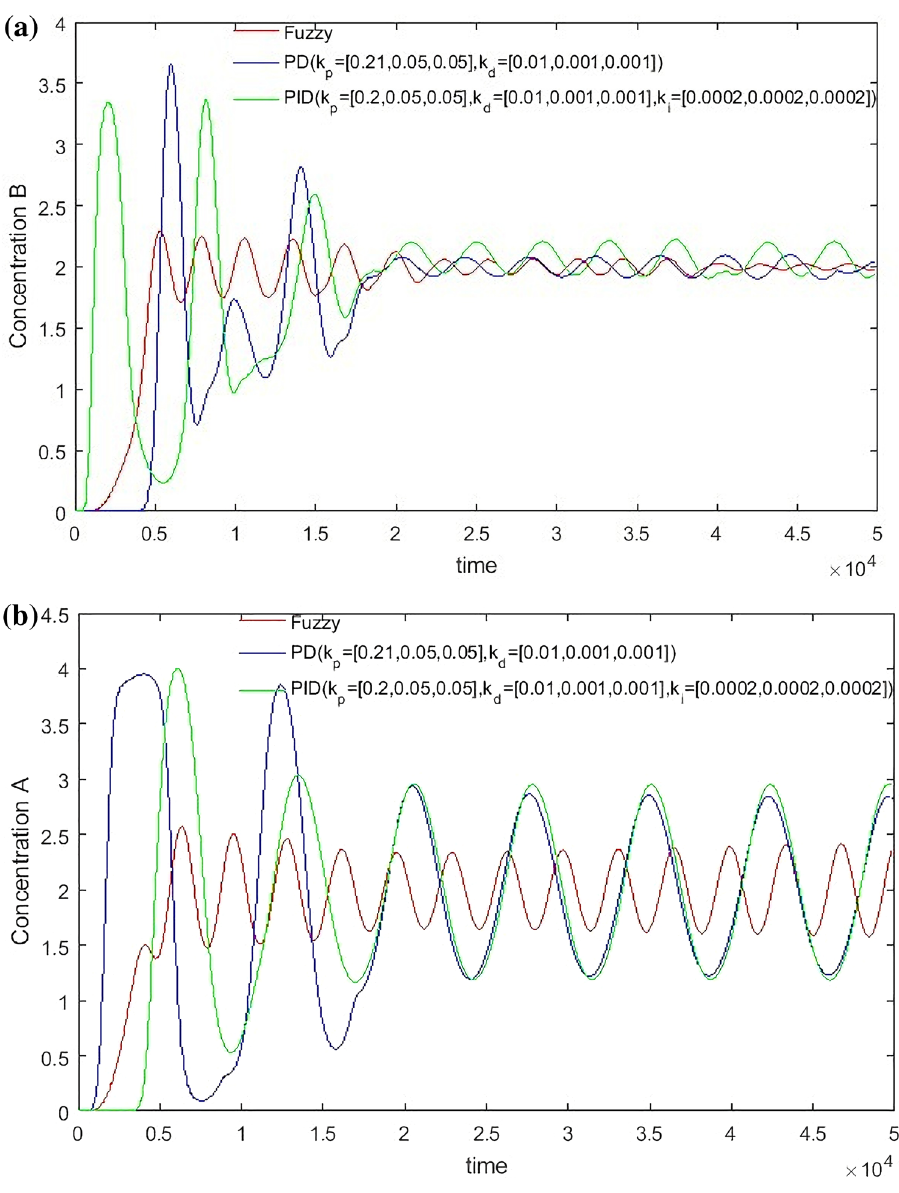
Figure 17. Desired B = 2, desired A = 2, Switch time = 180